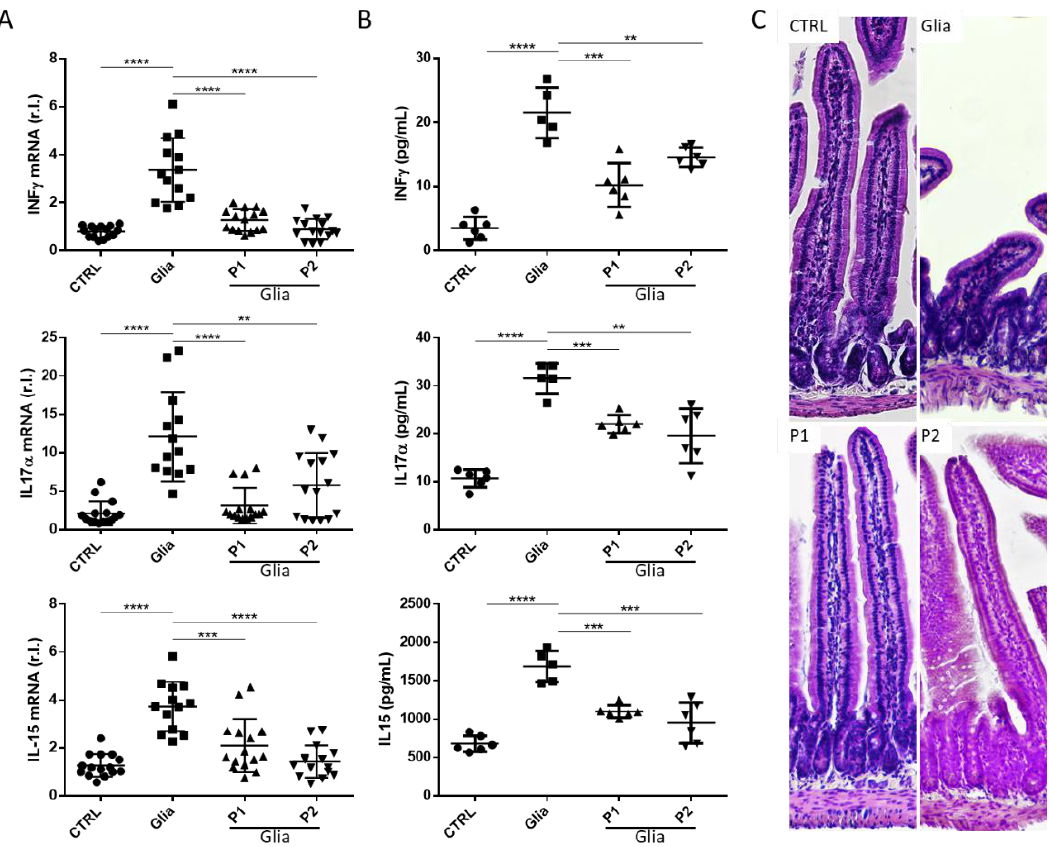
Figure 3. Anti-inflammatory activity of probiotics. IL-15, IL-17a, and INF γ mRNA ( A ) and protein ( B ) levels were evaluated in the small intestine tissue homogenate of Balb/c-fed third-generation gluten-free mice challenged with gliadin (GLIA) and P1 or P2 and compared to untreated control (CTRL) by qRT-PCR and ELISA, respectively. ( C ) H/E staining of small intestine from mice exposed (Glia), unexposed (CTRL) to gliadin alone or in combination with probiotic formulation 1 (P1) or 2 (P2). Images are representative of three independent experiments (magnification = 20 × ). Mean ± SD of triplicate sample **** p < 0.0001; *** p < 0.001; ** p < 0.01.